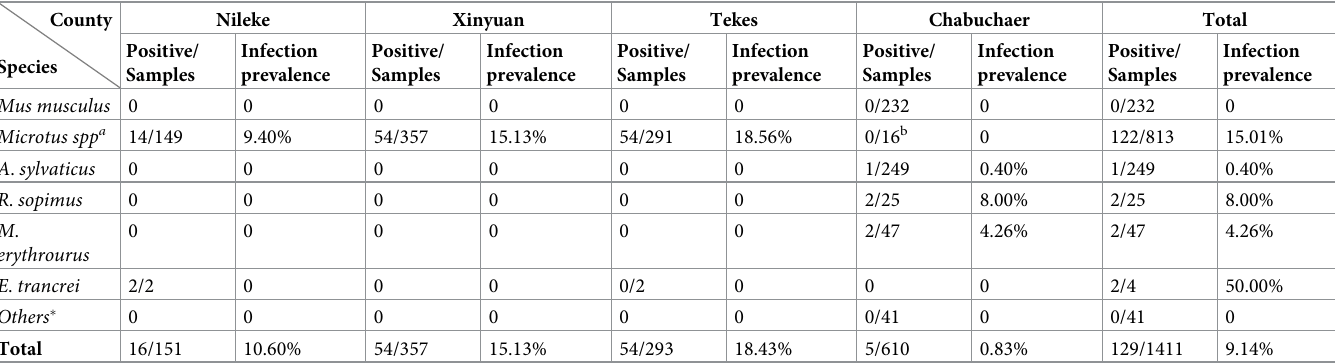
Table 5. Alveolar echinococcosis in small mammals in Yili Prefecture,